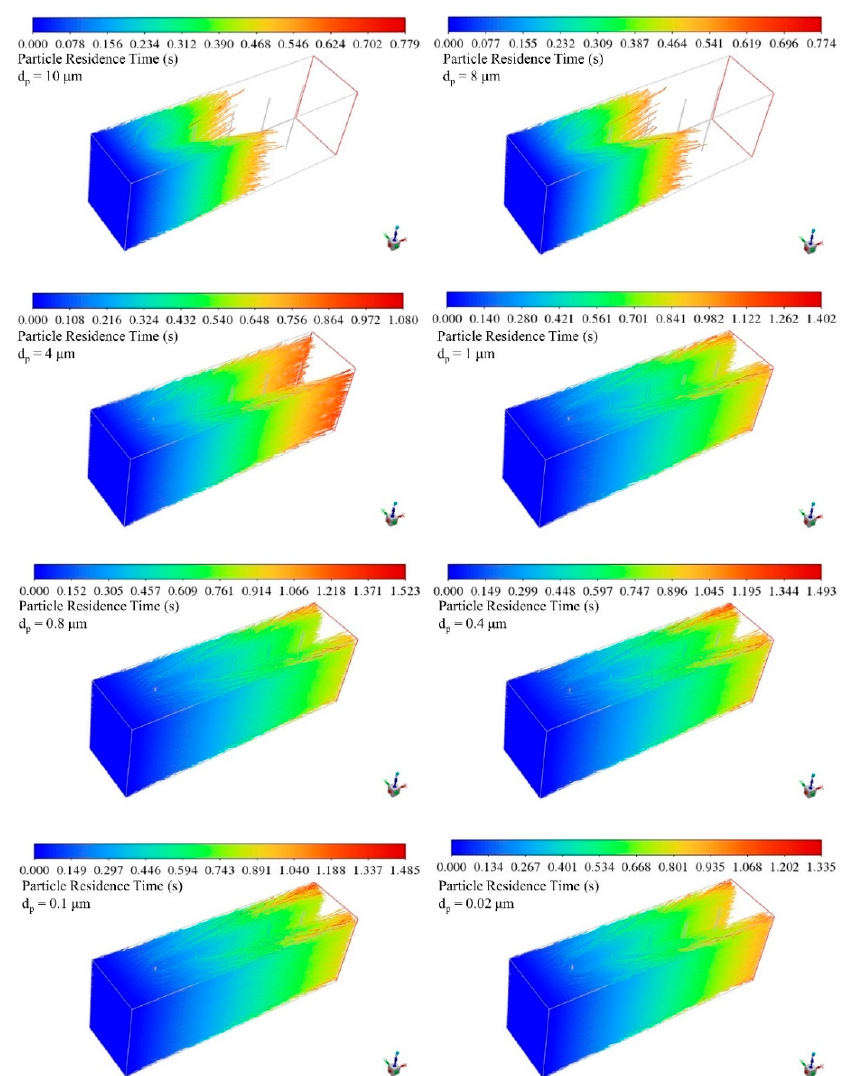
Figure 10. Particle tracking pathlines with respect to residence time for the case of d w = 1 mm, 55 kV, and U in = 1 m/s in the 230 mm wide channel.